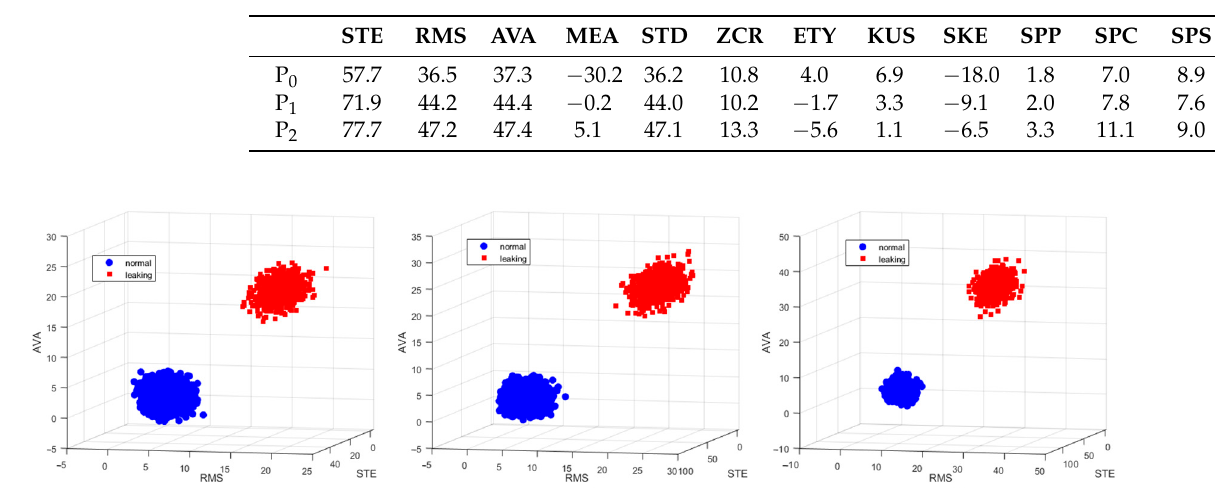
Table 3. Feature score based on KL distance.